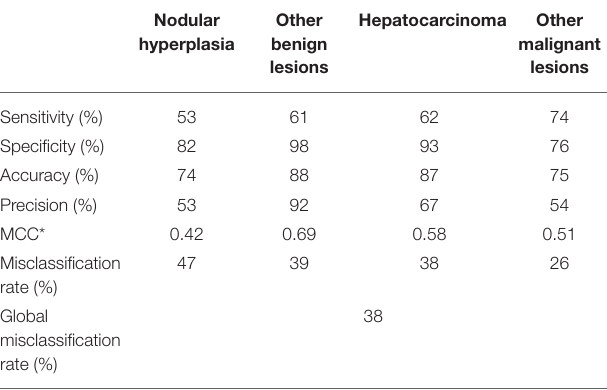
TABLE 4 | Complete results of the classification of the FLLs based on the machine learning-based decision